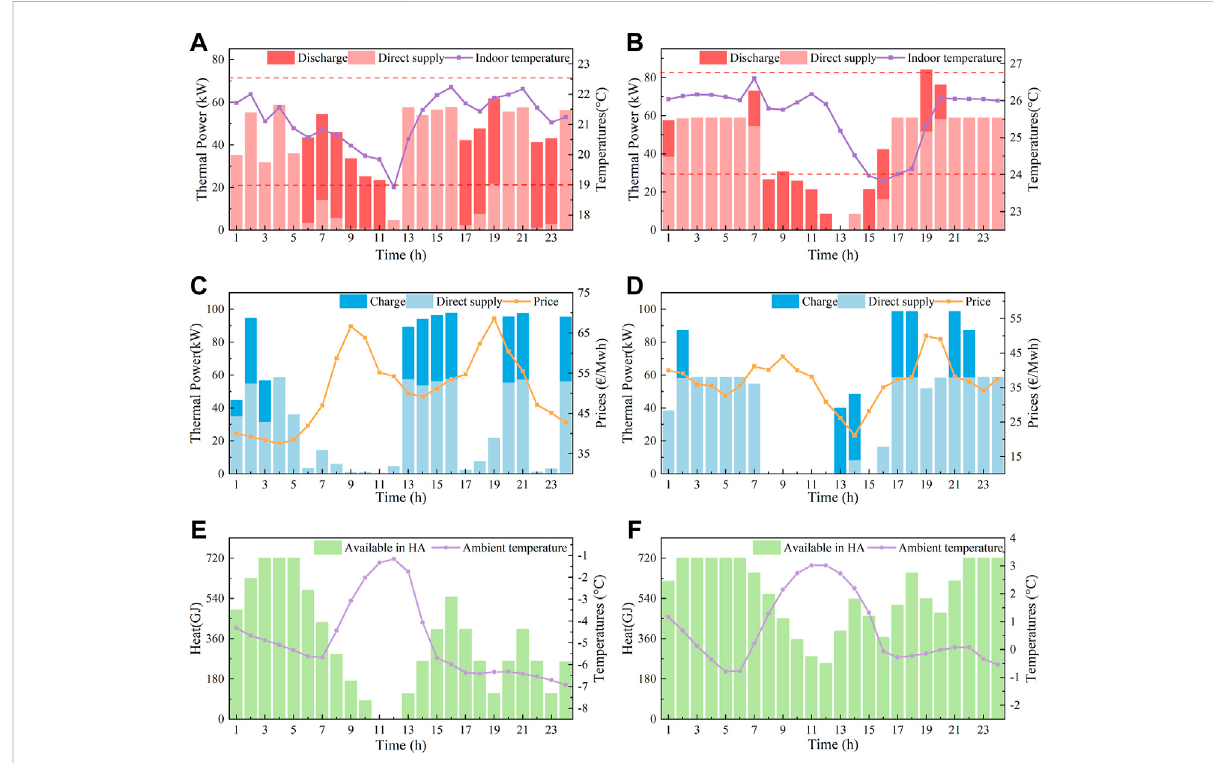
FIGURE 10 Scheduling results of 1 day in Scenarios 3 (left column) and 4 (right column) heating period: (A/B) output power of REB and average indoor temperatures, (C/D) input power of REB and electricity prices, and (E/F) available heat stored in heat accumulator and ambient